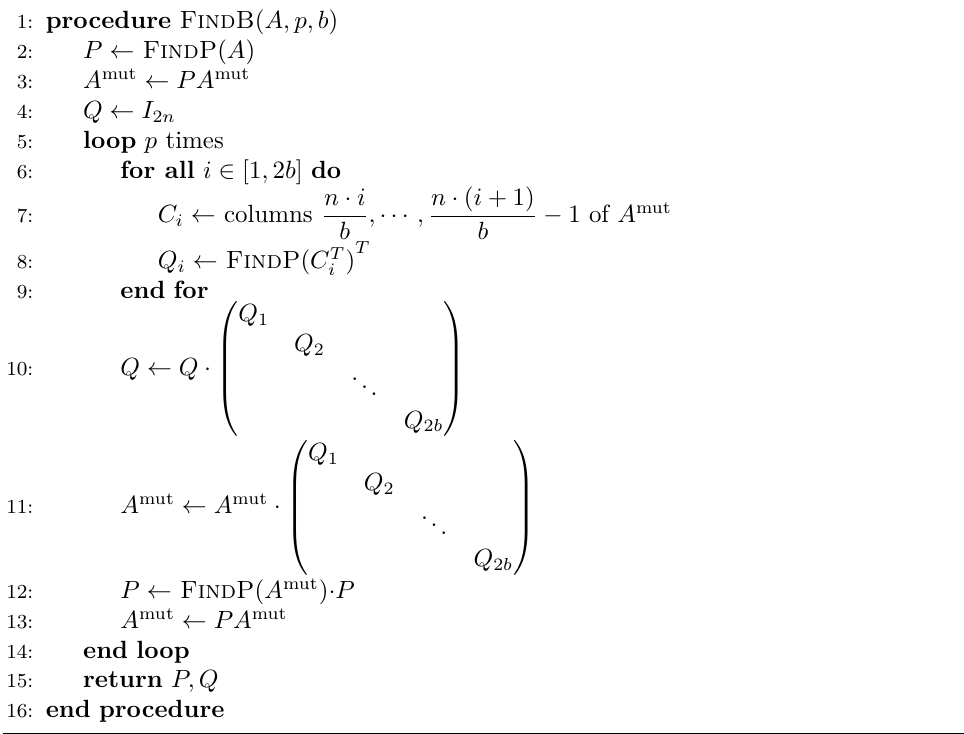
Algorithm 5 Given a matrix A of size n × N , find P ∈ GL n ( F 2 ) and block-diagonal Q with 2 b blocks such that ( P, Q ) minimizes P n